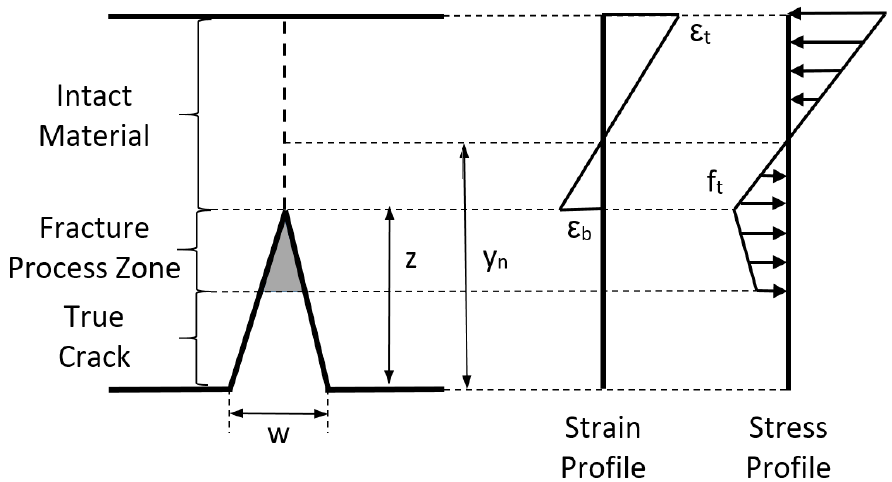
Figure 1. Material hypotheses. Cracked area is modeled according to the crack planar hypothesis and non-cracked area according to Navier’s hypothesis.